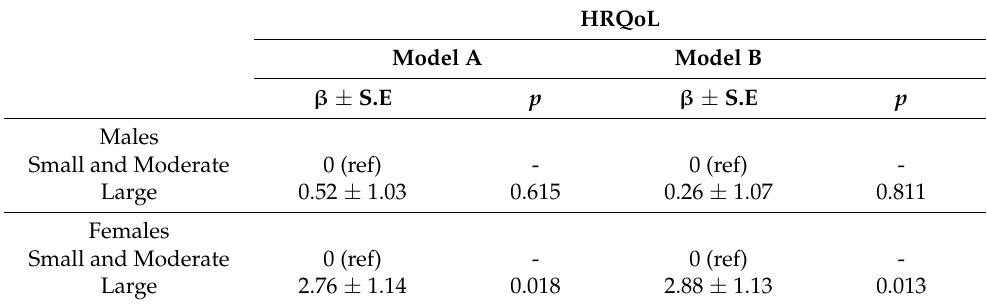
Table 5. Adjusted linear regression and 95% confidence interval (95%CI) of HRQoL by night meal